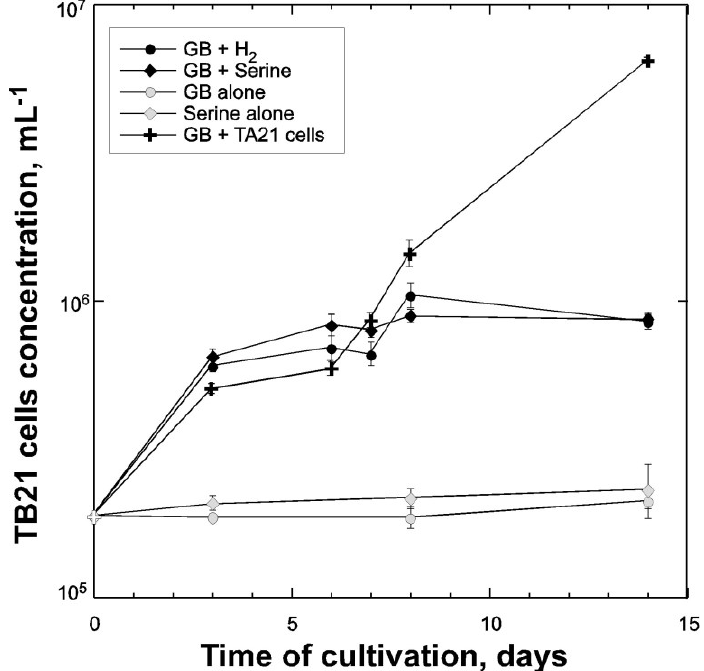
Figure 5. Growth of Halobacteroides lacunaris TB21 in liquid cultures with different substrates and with Methanohalophilus sp. TA21 cells. The growth of Halobacteroides lacunaris TB21 has been calculated from CARD-FISH-counting. Error bars indicate the standard deviation from triplicate